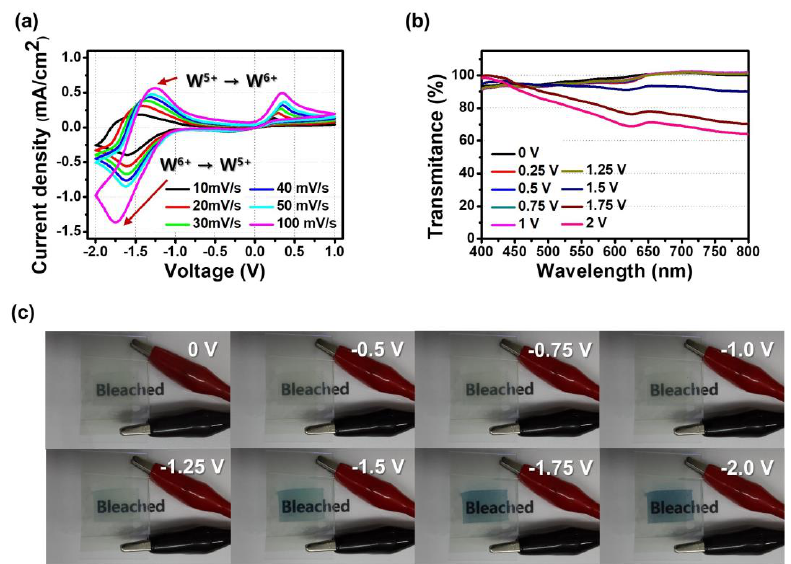
Figure 4. Electrochromic characteristics of a porous film of WO 3 @PEO fibers-based ECD with WO 3 :PEO = 1:1. ( a ) CV curves for different scan rates; ( b ) transmittance spectra for different applied voltages; ( c ) photographs of the ECD at differential voltage steps.